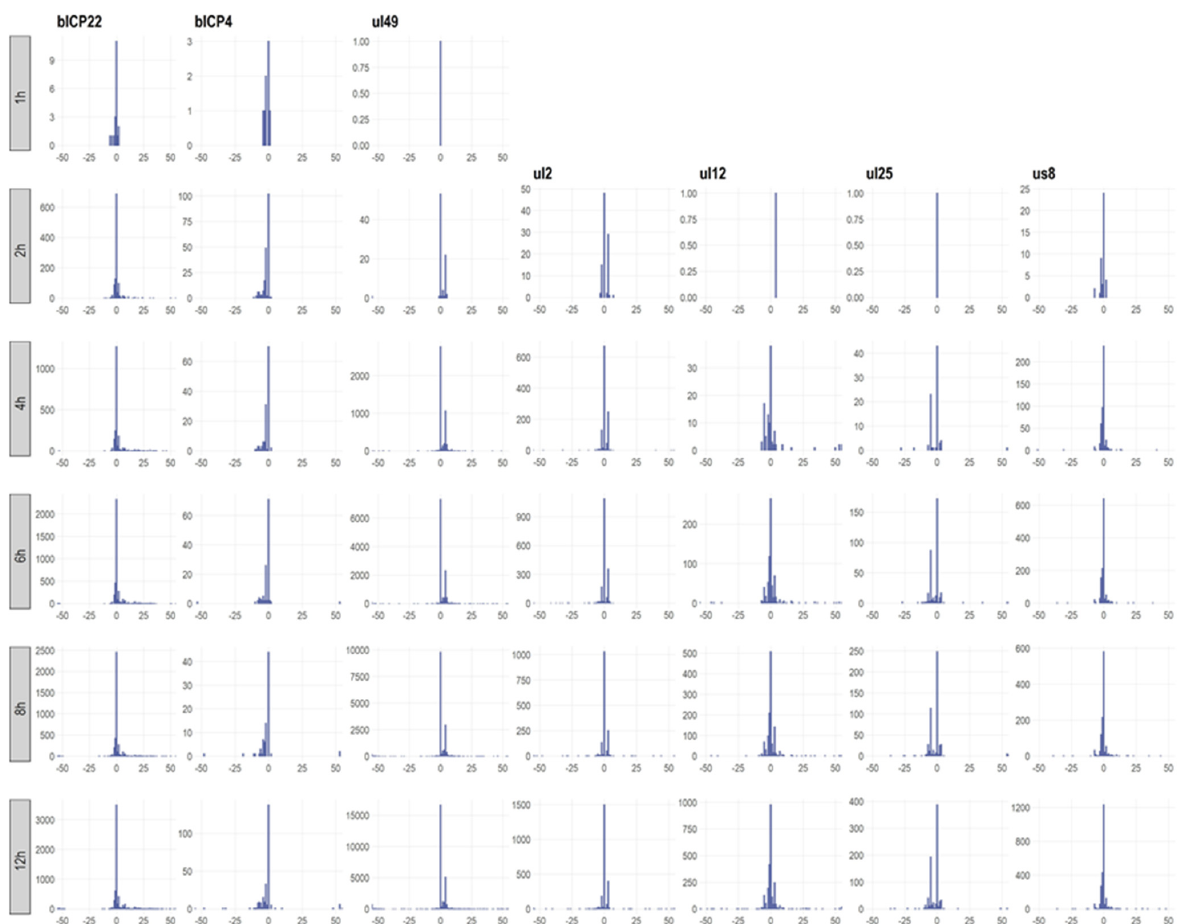
Figure 3. Dynamics of the transcription start site clusters. Promoters initiate transcription from multiple points with a dominant (canonical) TSS. Different promoters produce distinct patterns of TSS clusters, but a promoter generates similar TSS cluster compositions throughout the replication cycle of the virus. TSSs are expressed in a lower amount than canonical TSSs, which is not always man- ifested in the obtained TSS abundance of long transcripts due to the negative bias of LRS towards long reads.